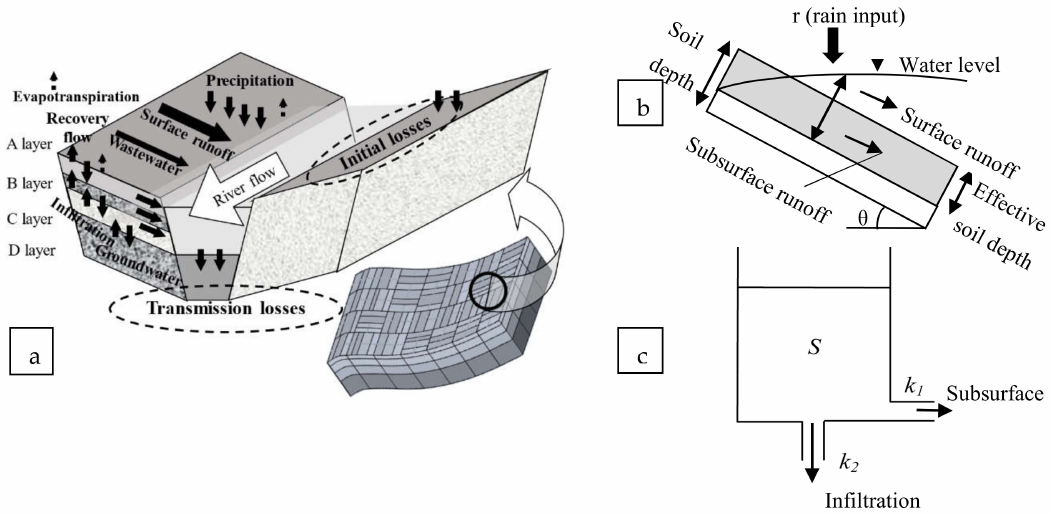
Figure 7. Hydro-BEAM schematic diagram (after Kojiri et al. [34]). ( a ) Hydro-BEAM basic structure; ( b ) surface layer kinematic wave model; ( c ) simple representation of subsurface storage tank